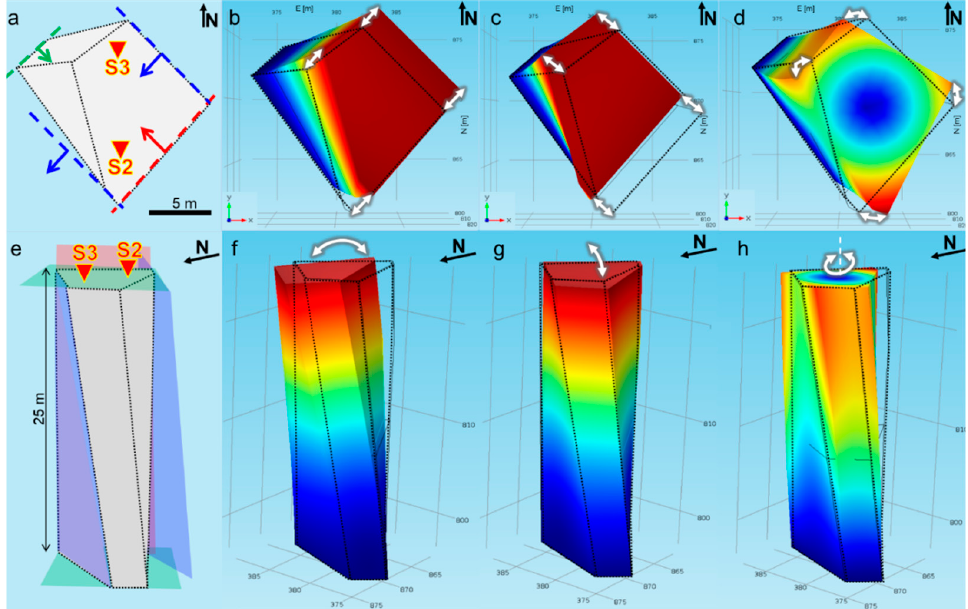
Figure 7. 3D numerical model of the quartzite tower. ( a – d ) planar view, ( e – h ): frontal view. ( a , e ) Initial model geometry with indication of the delimiting fracture orientations (K1 in red, K2 in blue, K3 in green) and sensor locations (S2 and S3). ( b , f ): First, ( c , g ): second, ( d , h ): third vibration mode. White arrows mark the vibration direction from the undeformed volume (dashed black contour). The color scale (from blue to red) indicate increasing amount of displacement.